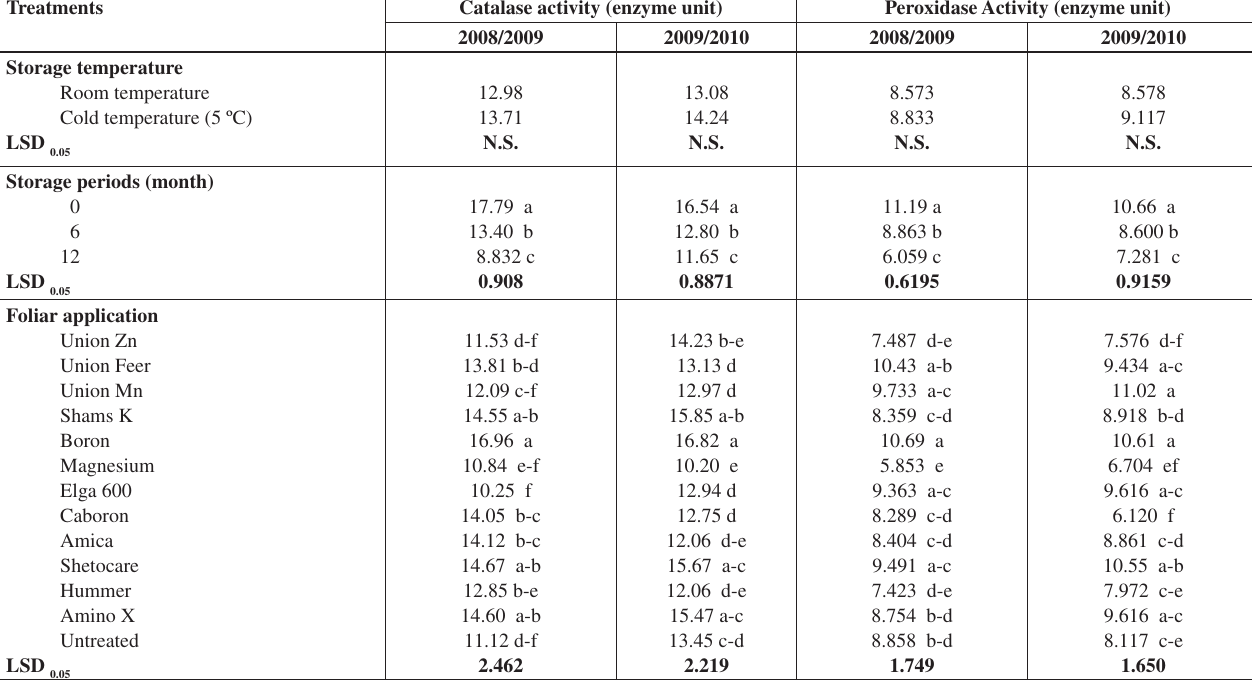
Table 15: Effect of storage temperature, storage period and foliar application with commercial compounds on catalase and peroxidase activity of onion seeds during seasons of 2008 / 2009 and 2009/2010 Treatments